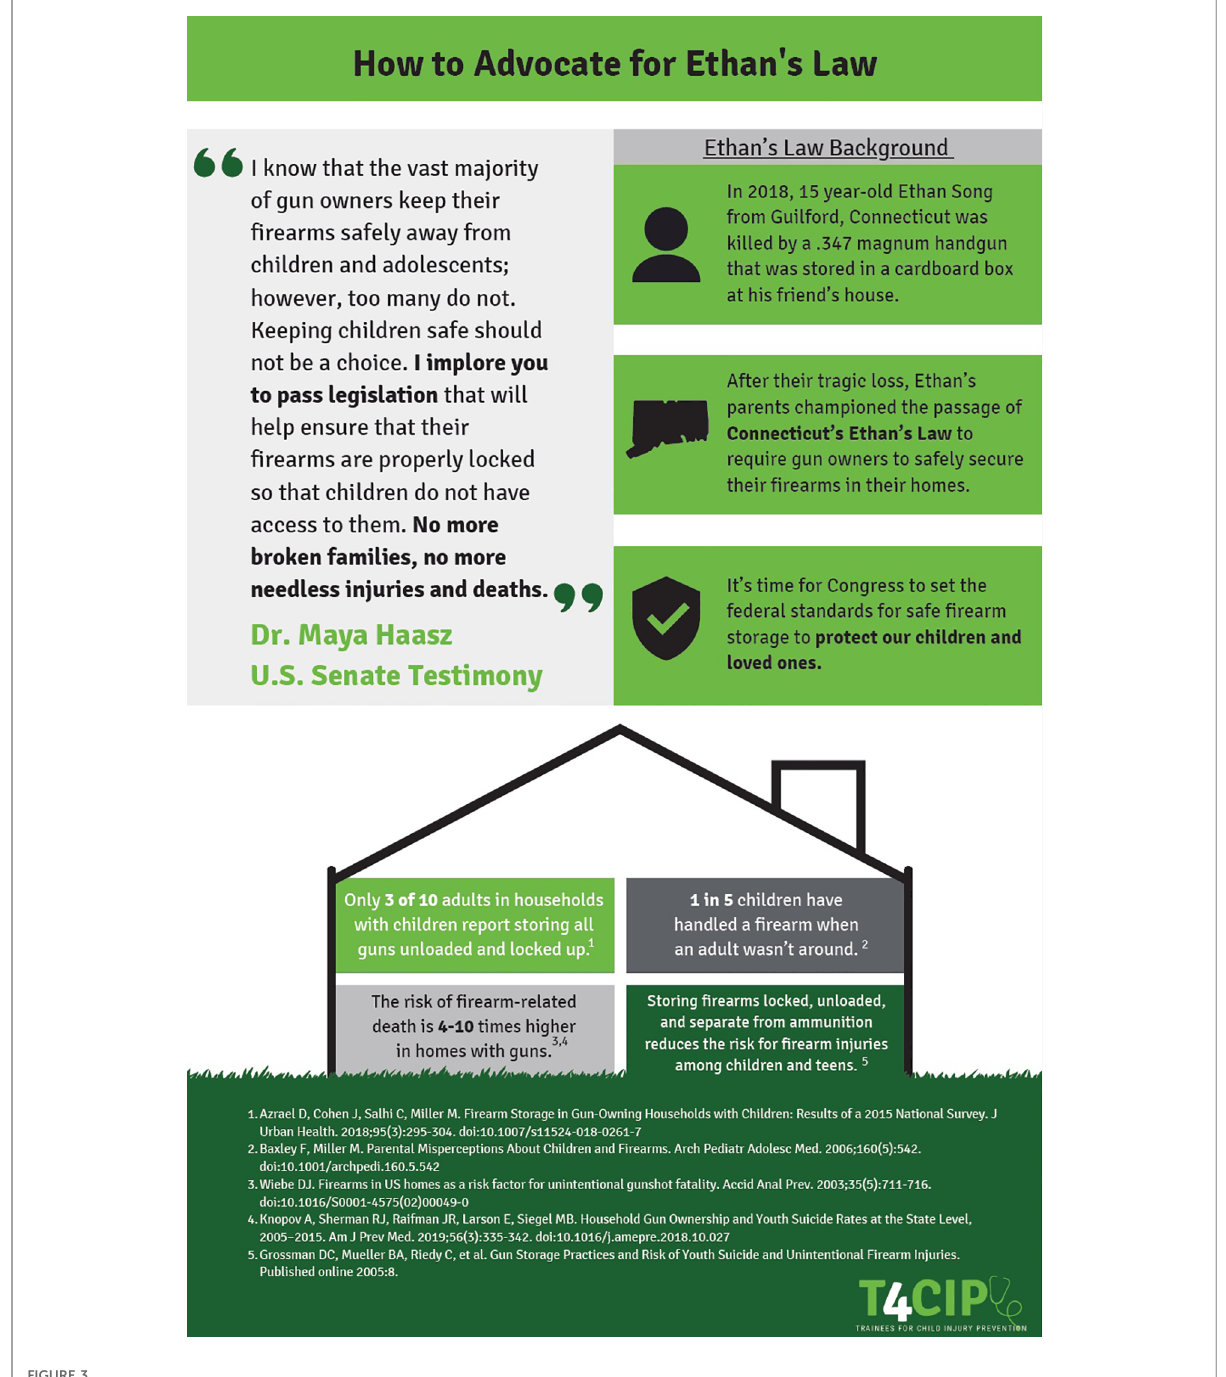
FIGURE 3 Second Policy “ Guide ” : Child access prevention laws part